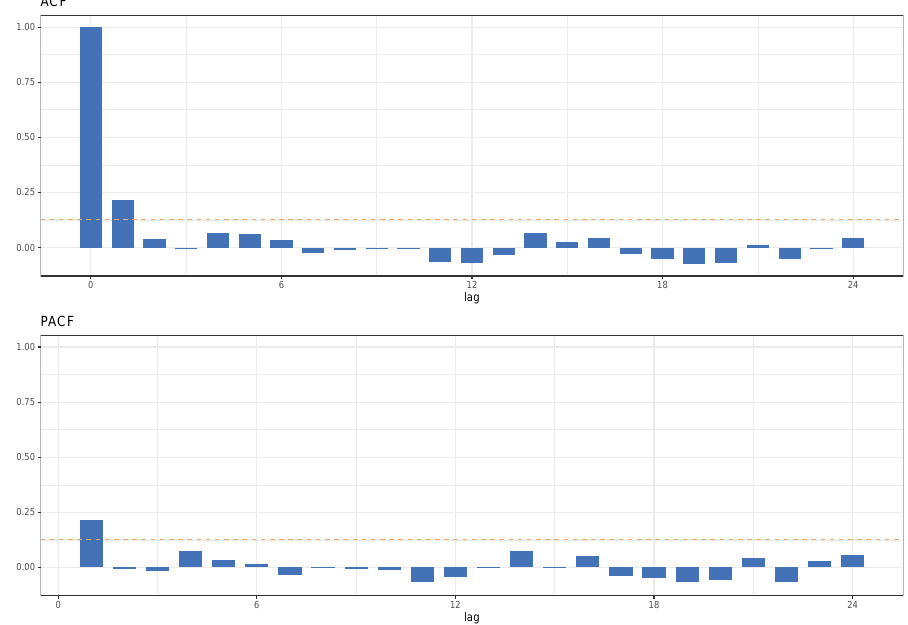
Figure 9. Estimated auto-correlations of the dataset IPs : ( top panel ) autocorrelation function (ACF); ( bottom panel ) partial autocorrelation function